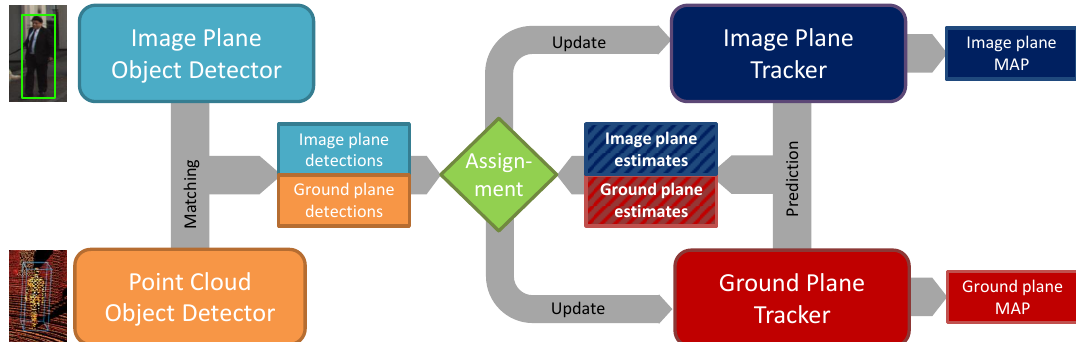
Figure 1. A simplified schematic depicting the various paths of information flow and feedback between sub-components in the proposed system. Left : CNN detections, in blue, are matched to 3D segments originating from the LiDAR, in orange. Right : image plane tracker, shown in blue, and ground plane tracker, in red, form predictions and updates. Center : matching of observations and track estimates are done by optimizing the joint observation log-likelihood, in